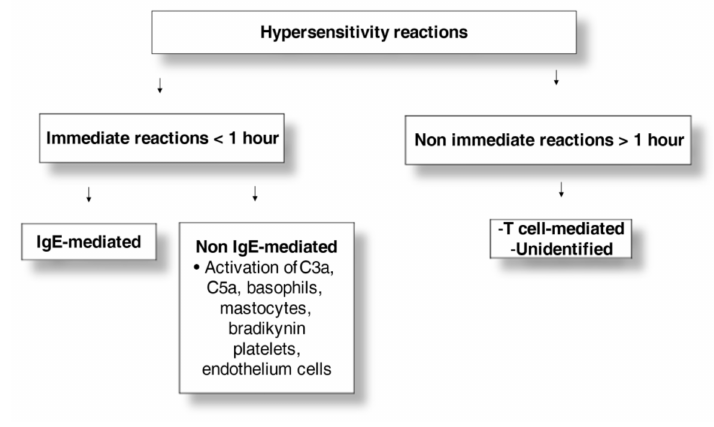
Figure 1. Hypersensitivity reactions to radiocontrast